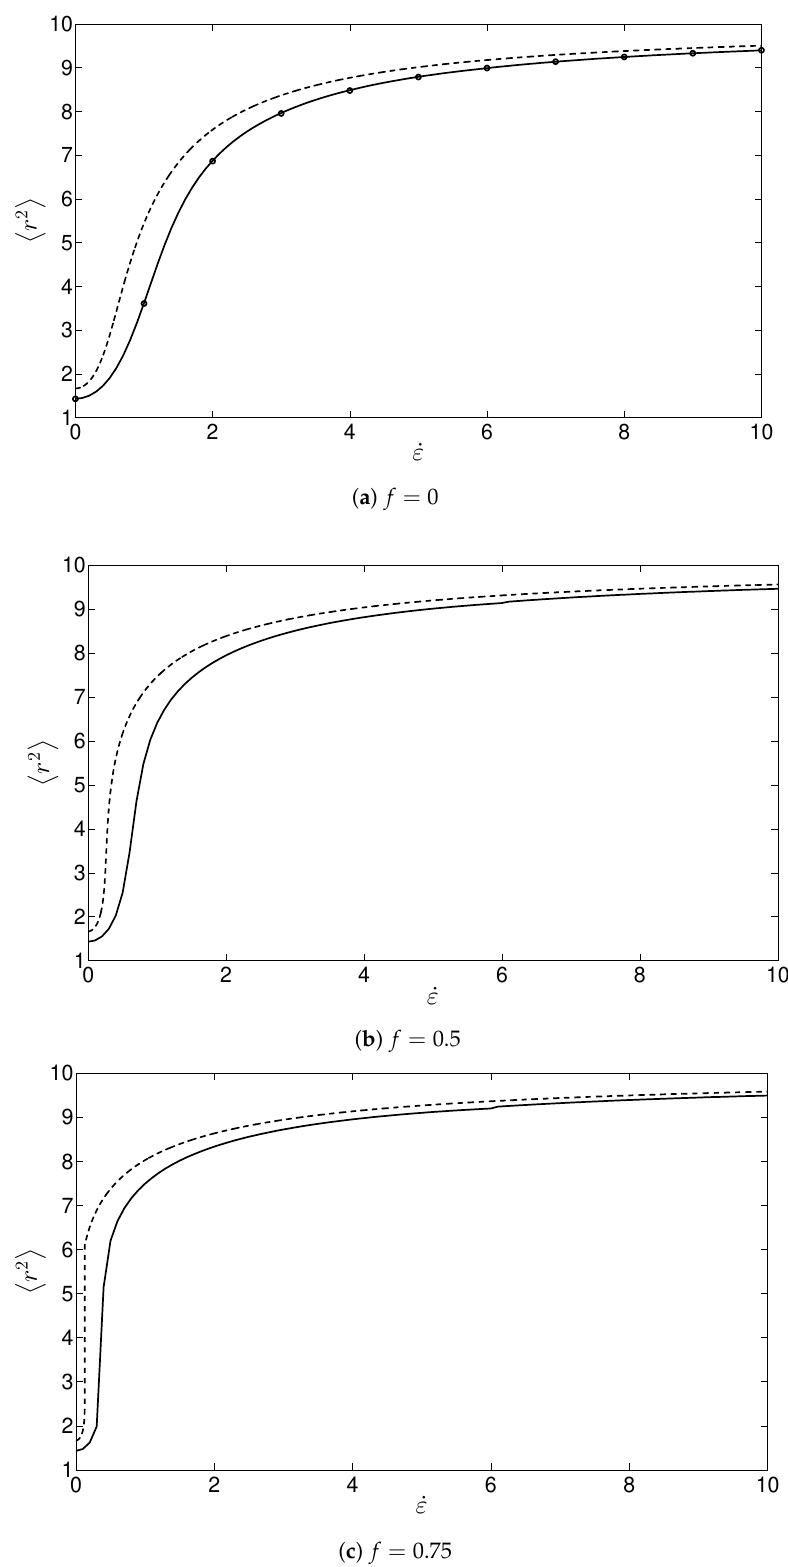
(cid:10) (cid:11) r 2 plotted against the non-dimensional